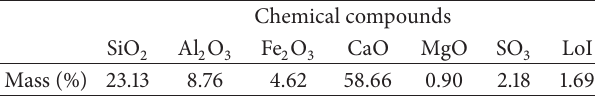
Table 1: Chemical composition of Portland cement.